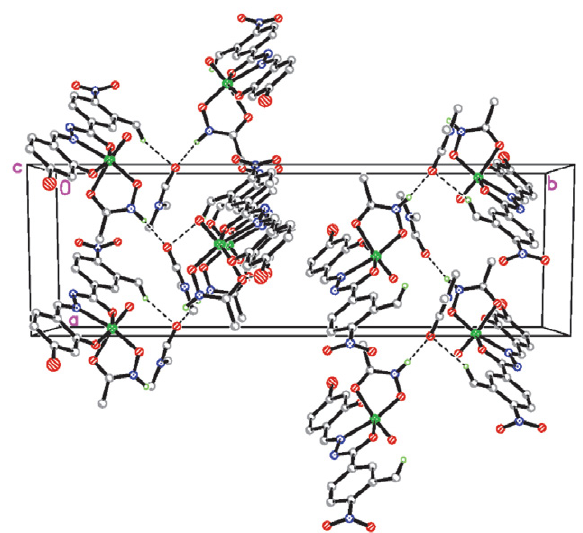
Fig. 3. Molecular packing structure of complex 1 linked by hydro- gen bonds (dashed